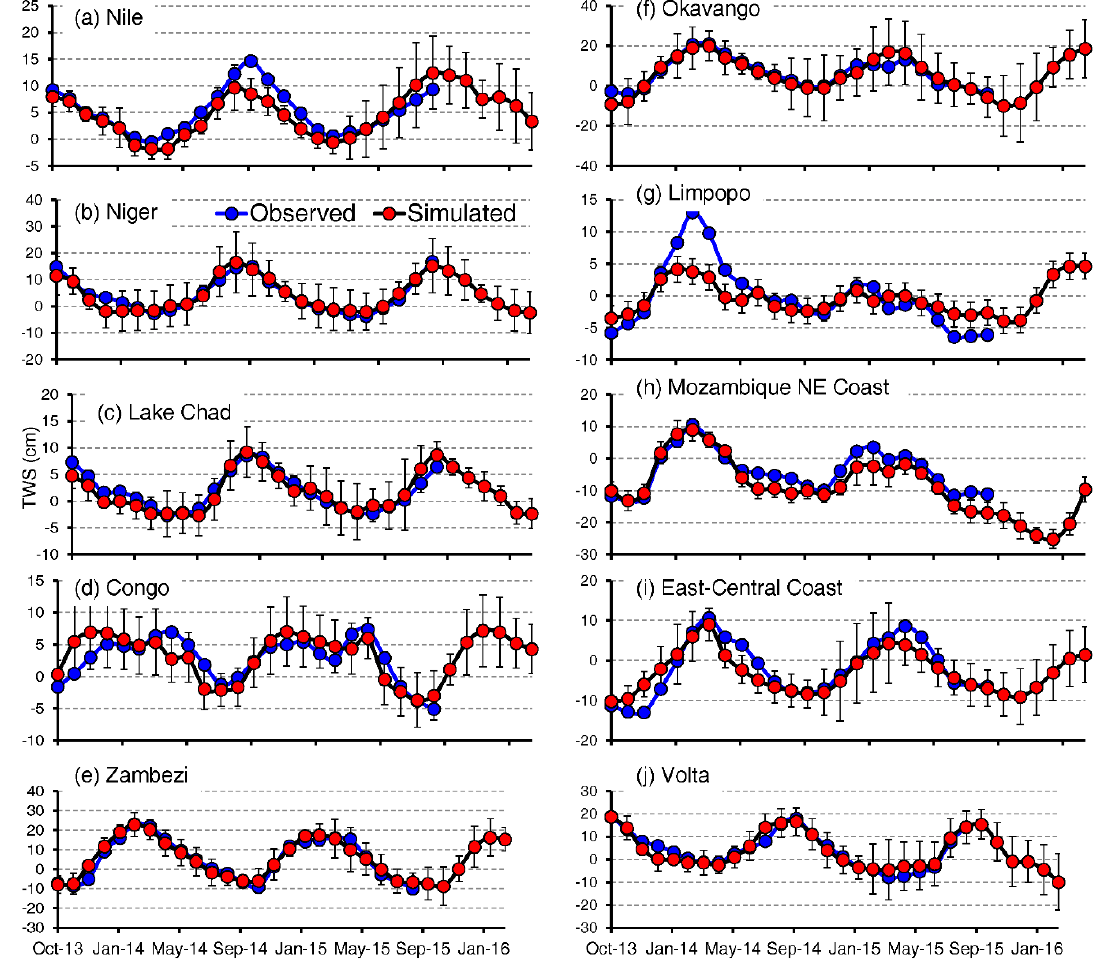
Figure 4. Nonlinear autoregressive with exogenous input (NARX) model predictions (October 2013–September 2015) and forecasting (October 2015–March 2016) results over 10 African watersheds ( a – j ). Blue and red lines show the observed and simulated terrestrial water storage (TWS) GRACE measurements, respectively.